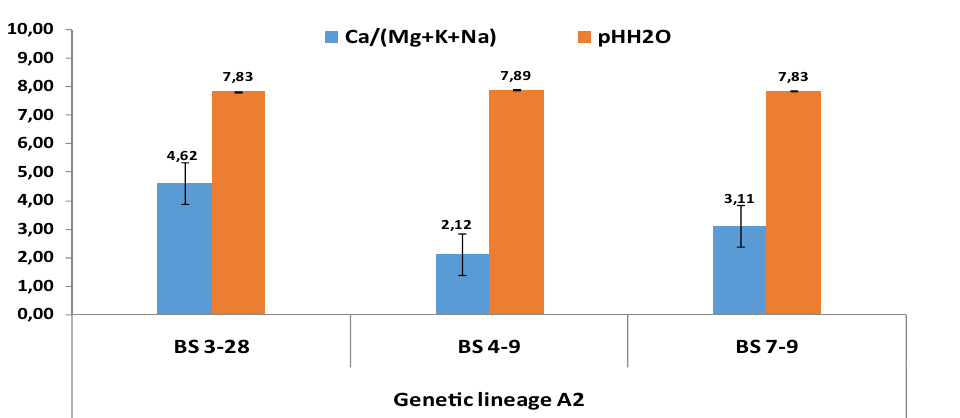
Figure 5. Singular site specific index of active forms of alkaline elements (Ca, Mg, K, Na) and pH in the growth media of A. pinguis cryptic species A genetic lineage A2 at Beskidy Mts.